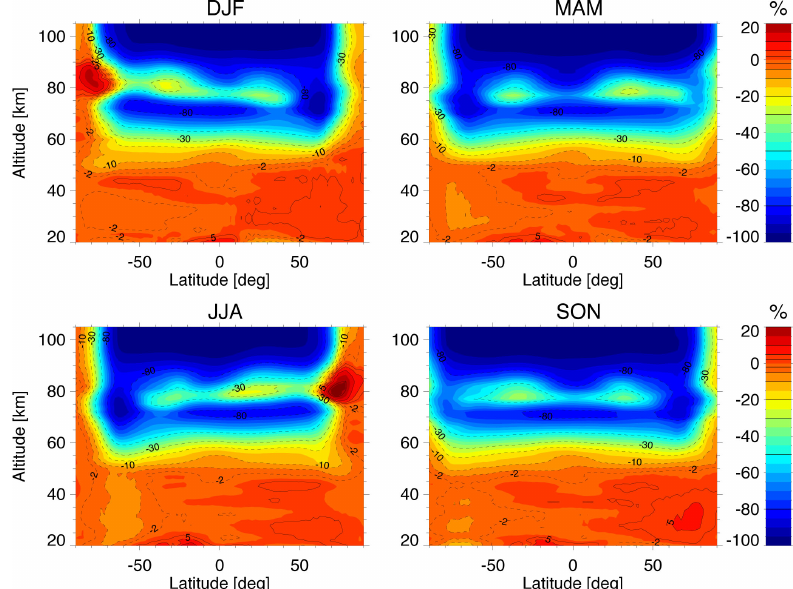
Figure 13. Composite seasonal zonal mean of O 3 diurnal differences (10:00–22:00LT in percentage of 22:00LT measurements) of MIPAS data taken in the MA mode for the 2007–2012 period. DJF stands for December, January, and February; MAM for March, April, and May; JJA for June, July, and August; and SON for September, October, and November. Contours are − 80, − 50, − 30, − 20, − 10, − 5, − 2, 2, 5, 10, and